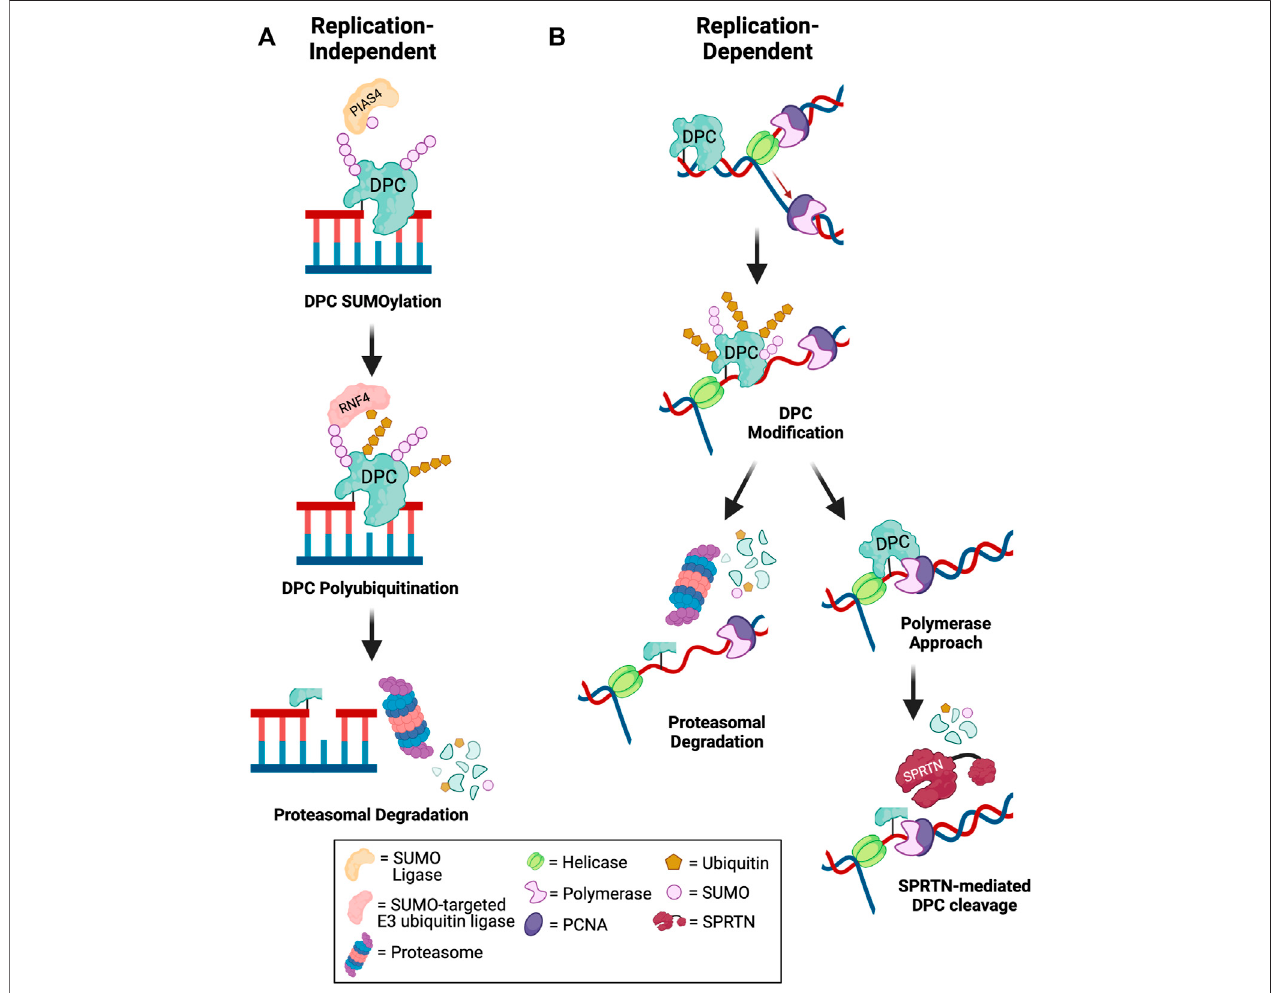
FIGURE 2 | Mechanisms of DPC degradation. Schematic depicting pathways for debulking of DPCs in (A) replication-independent and (B) replication-dependent contexts. (A) OutsideofDNAreplication,DPCsaretargetedforSUMOylationbyanE3SUMOligasesuchasPIAS4.SubsequentDPCrecognitionandpolyubiquitination by a SUMO-targeted E3 ubiquitin ligase such as RNF4 promotes proteasomal degradation ofthe DPC to allow for downstream repair of DNA breaks (Sun et al., 2020c; Liuetal.,2021). (B) DuringDNAreplication,forkcollisionwithaDPCtriggershelicase-polymeraseuncouplingbyCMGhelicasebypassofthelesion.TheDPCmay be targeted for modi fi cation by ubiquitin or SUMO. Polyubiquitinated DPCs can be targeted for proteasomal degradation. Alternatively, if the polymerase extends the nascent DNA to within a few nucleotides of the lesion, SPRTN-mediated DPC proteolysis is activated to degrade modi fi ed or unmodi fi ed DPCs. The remaining peptide- DNA adduct can be bypassed by TLS polymerases and repaired post-replication (Larsen et al., 2019; Sparks et al., 2019; Ruggiano et al., 2021). Created in